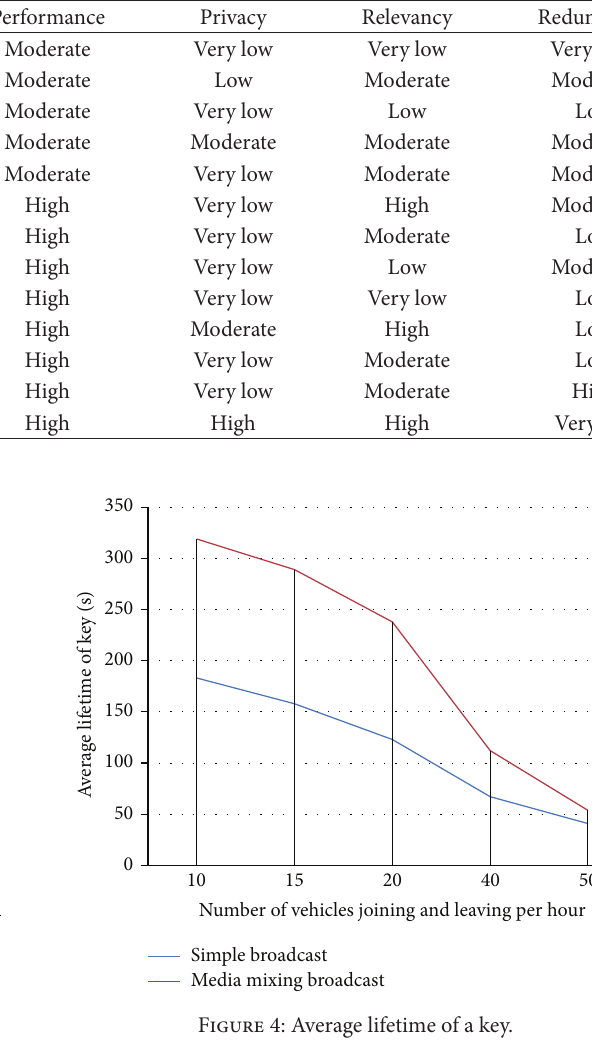
Figure 3: Average number of messages received by each user.